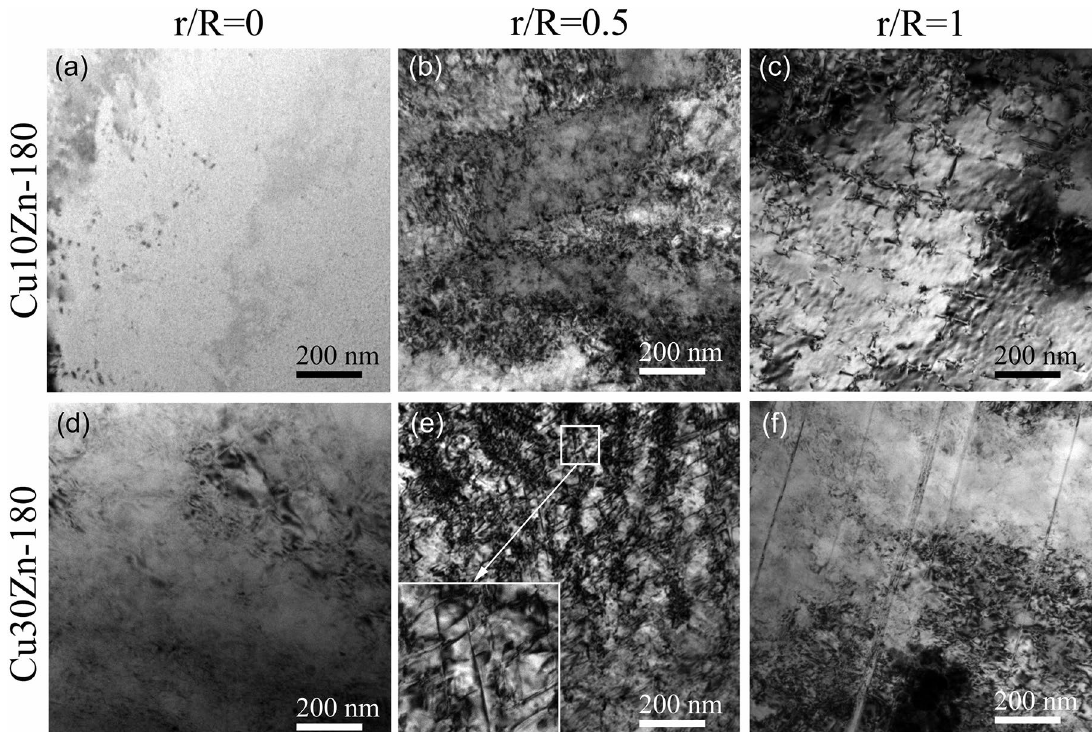
Figure 3. Engineering strain-engineering stress curves of the (a) Cu10Zn and (b) Cu30Zn alloys before and after pre-torsional treatment, and the corresponding strain hardening rate curves of (c) Cu10Zn and (d) Cu30Zn alloys.